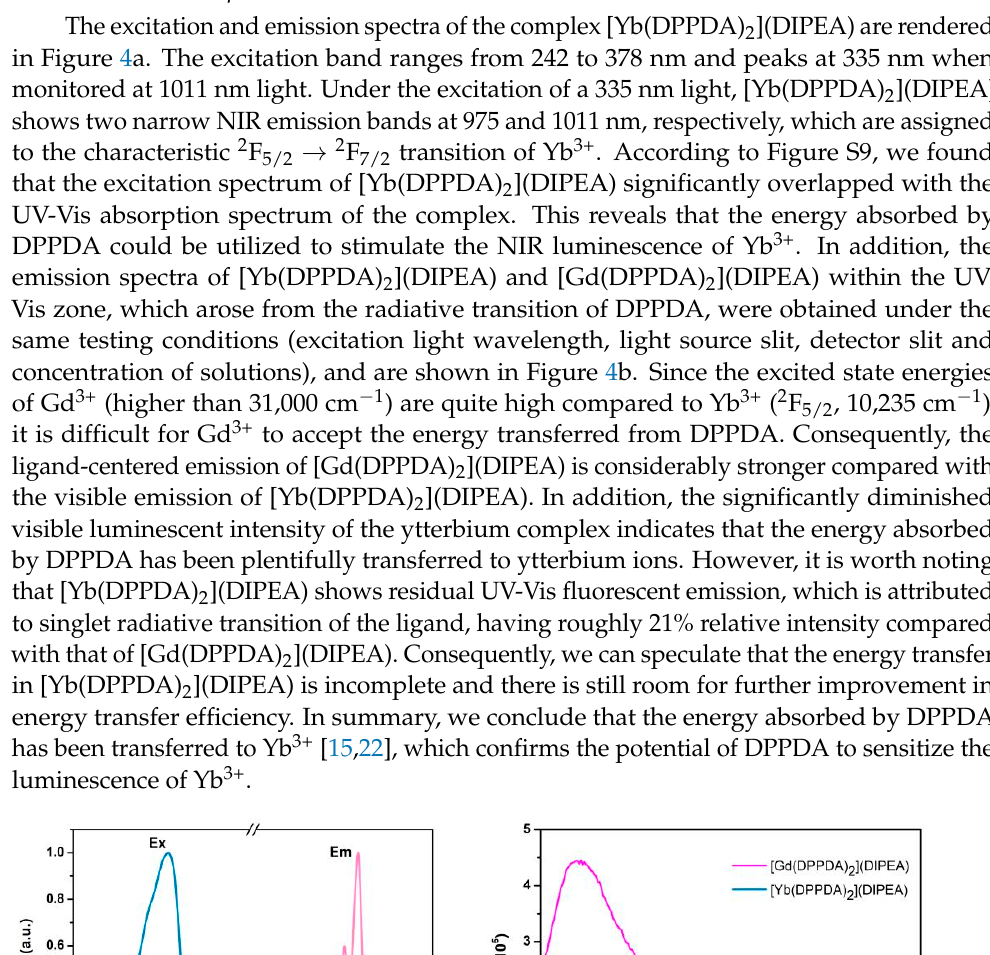
luminescent lifetimes ( τ obs ) of [Yb(DPPDA) 2 ](DIPEA) are calculated and summarized in